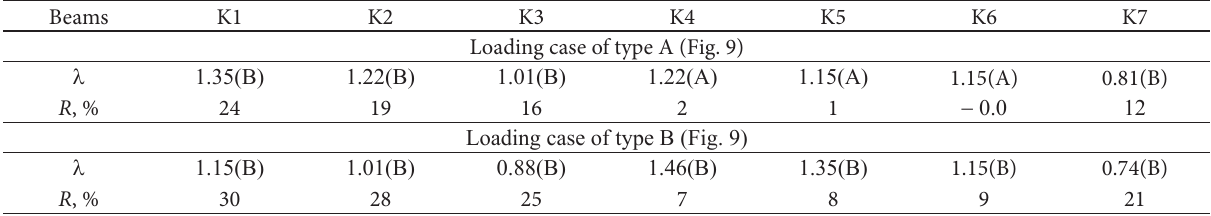
Table 7. Hogging and sagging bending – See Table 4 (class 4) – All options – Local buckling not included Beams